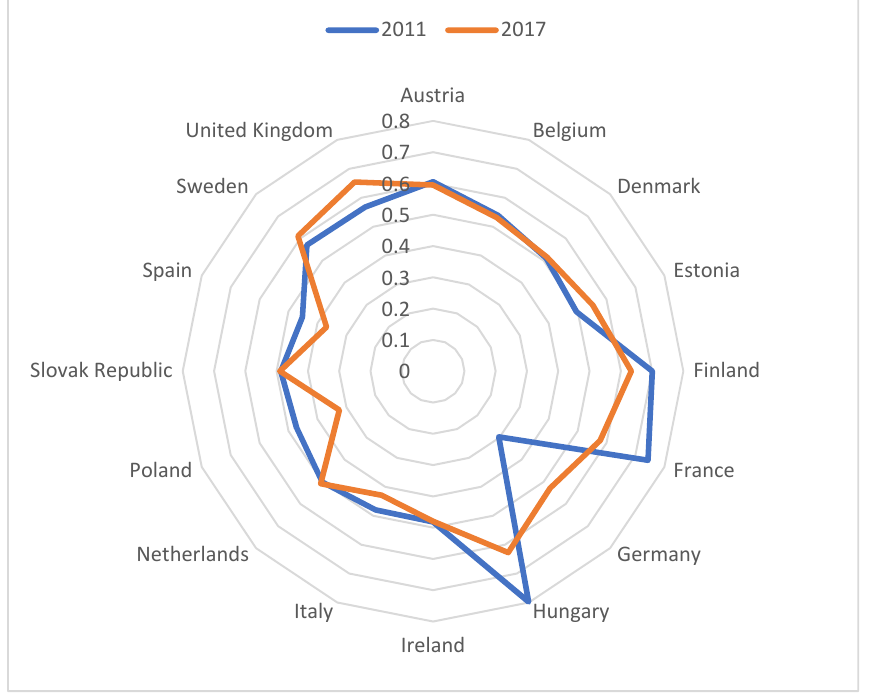
Figure 3. The average level of environmental performance of the Energy efficiency R&D (million USD and PPP) for selected EU countries in 2011 and 2017.